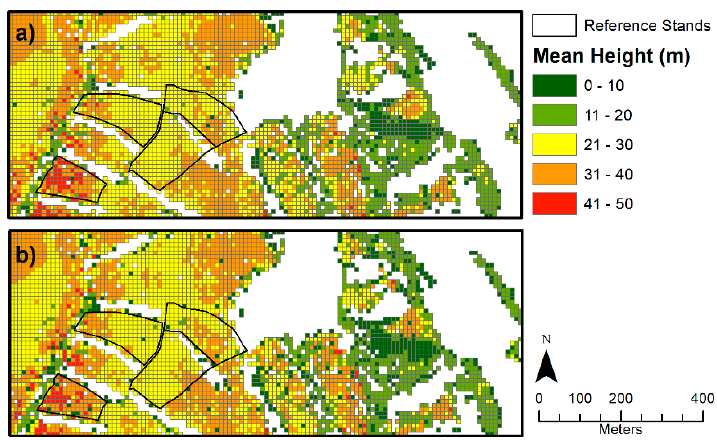
Figure 3. Maps of mean height over grid cell (10 × 10 m): ( a ) Multisource-based method and ( b ) raster-based method.